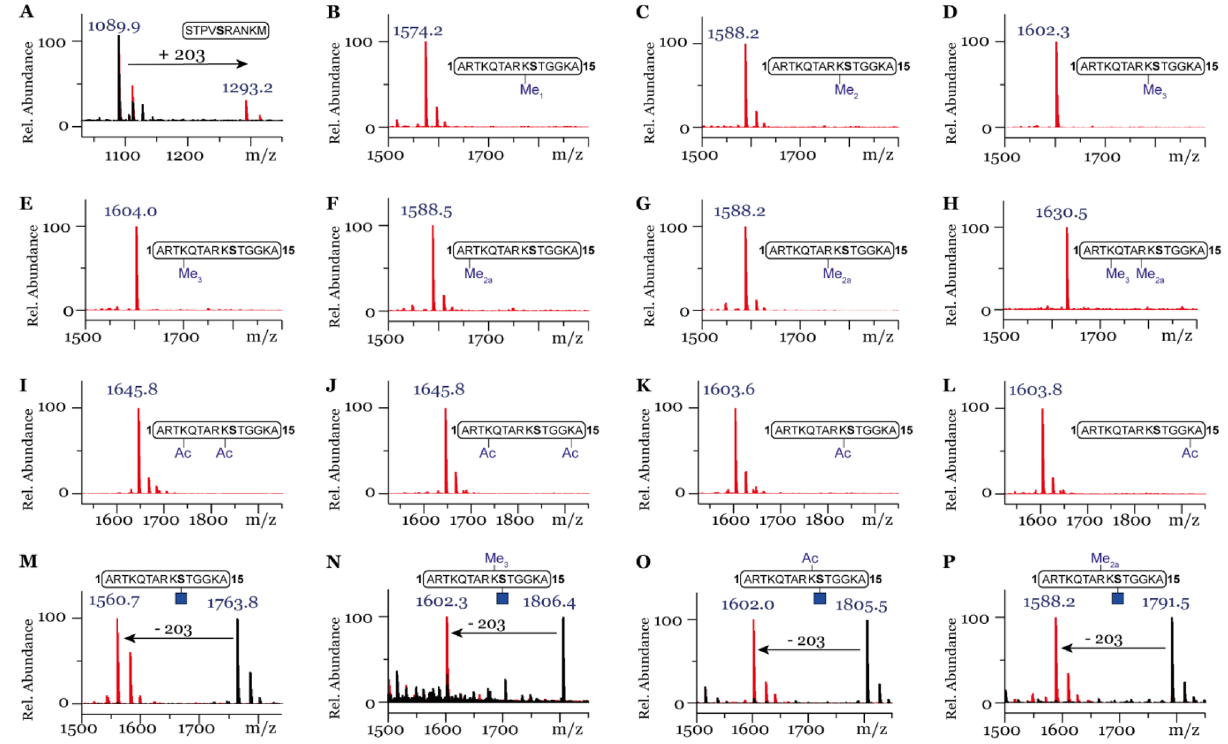
Figure 3. MALDI-TOF MS data showing glycosylation in the presence of OGT with ( A ) Control peptide. No glycosylation observed with peptides: ( B ) H3K9Me, ( C ) H3K9Me2, ( D ) H3K9Me3, ( E ) H3K4Me3, ( F ) H3R2Me2a, ( G ) H3R8Me2a, ( H ) H3K4Me3R8Me2a, ( I ) H3K4AcK9Ac, ( J ) H3K4AcK14Ac, ( K ) H3K9Ac, ( L ) H3K14Ac. OGA efficiently hydrolyses ( M ) H3S10GlcNAc, ( N ) H3K9Me3S10GlcNAc, ( O ) H3K9AcS10GlcNAc, ( P ) H3R8Me2aS10GlcNAc. Red spectra show 1 h reactions at 37 °C with 5 µM OGT, 50 µM UDP-GlcNAc ( A – L ) or with 1 µM OGA ( M – P ) and black spectra the no-enzyme